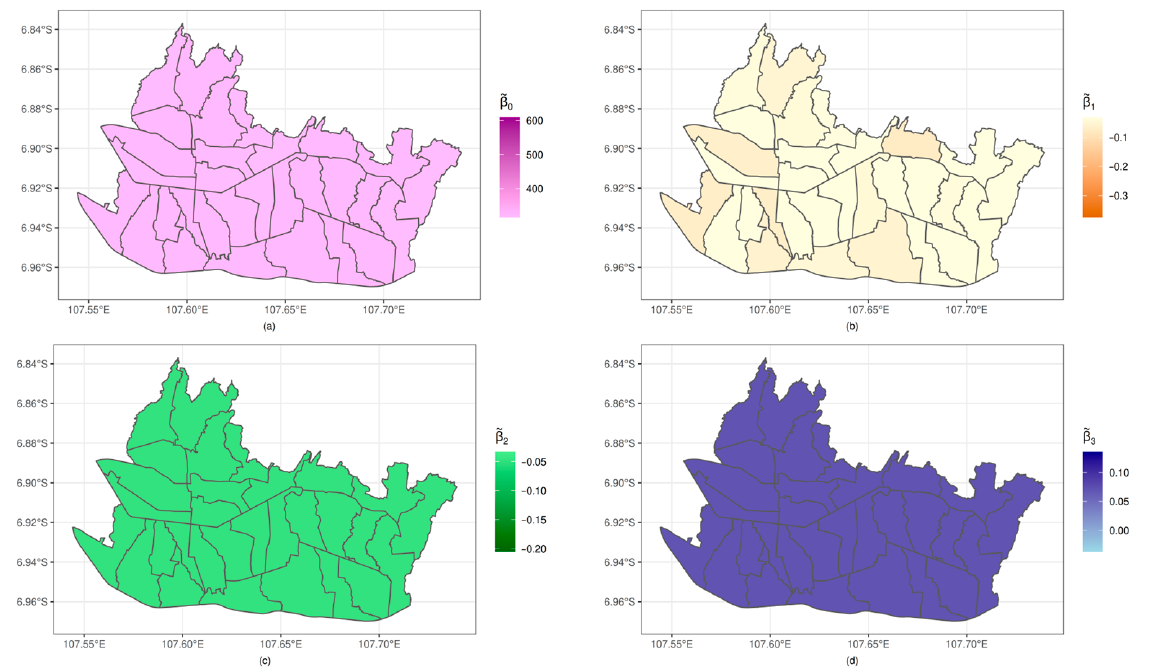
Figure 4. Coefficient maps of space variable for quantile 0.25 of dengue fever in Bandung city from 2017–2021 (( a ) for intercept, ( b ) for slope 1, ( c ) for slope 2, and ( d ) for slope 3).